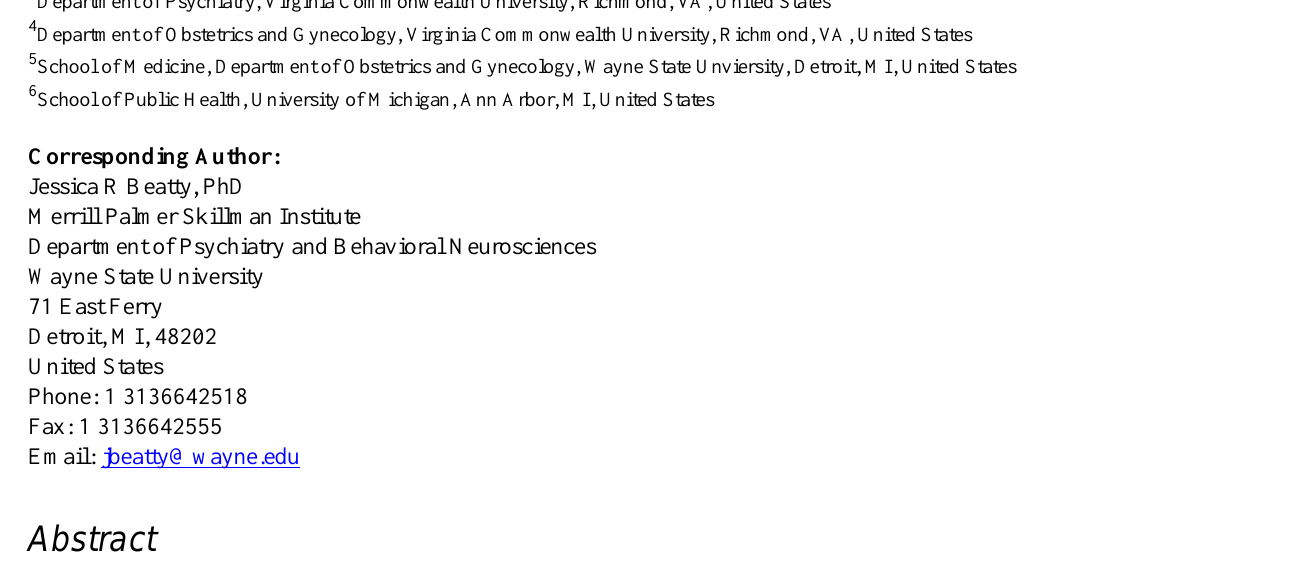
pregnancy; marijuana; intervention study; text